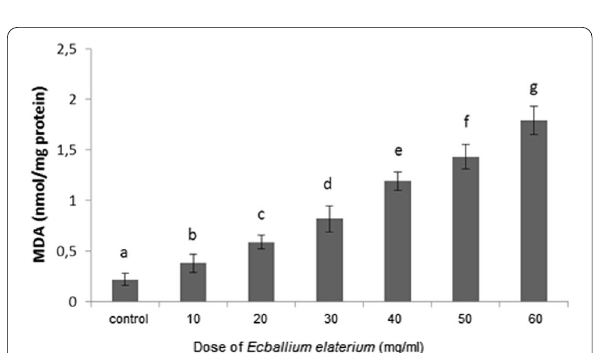
Fig. 2 Effect of E. elaterium fruit juice on MDA levels of G. mellonella larvae. *Letters above bars indicate significant differences between concentrations. Bars with the same letter are not significantly different. Error bars indicate standard deviation (SD) of